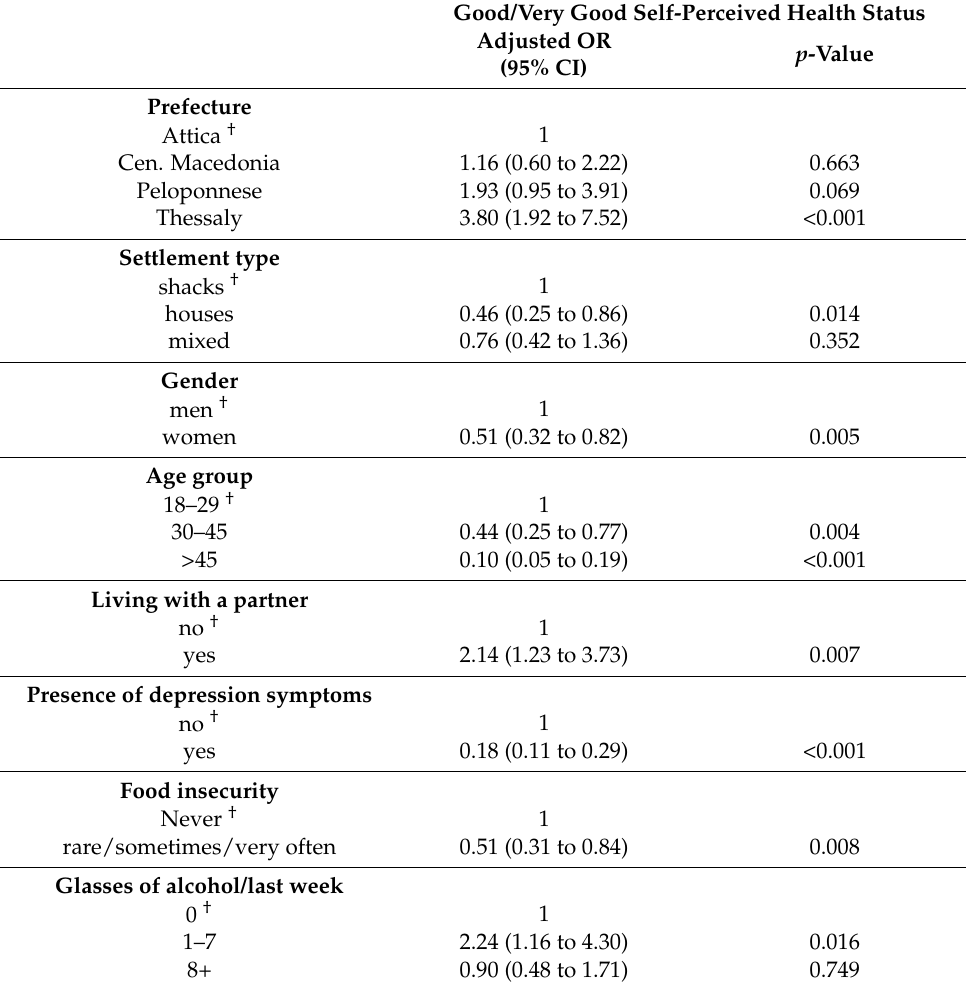
Table 3. Factors associated with the self-perceived health status of Roma living in Roma settlements in Greece. Results from multivariable logistic regression comparing those who had good or very good self-perceived health status with those who had fair, bad, or very bad self-perceived health